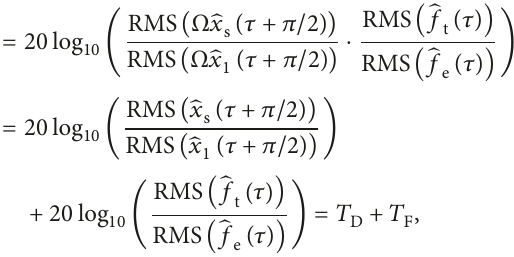
Figure 2: The frequency response curve (FRC) of the two-stage HSLDS isolation system. The parameters are 𝜇 1 = 0.2 , 𝜇 2 = 1 , 𝜆 1 = √5 , = 1 , ̂𝑘 = 1 , ̂𝑘 = ̂𝑘 = 0.9 , ̂𝑙 = 0.7 , ̂𝐹 = 0.01 , and 𝜁 𝜆 2 s h 1 h 2 stable solution (blue line) and unstable solution (red dashed line). Numerical solution: black